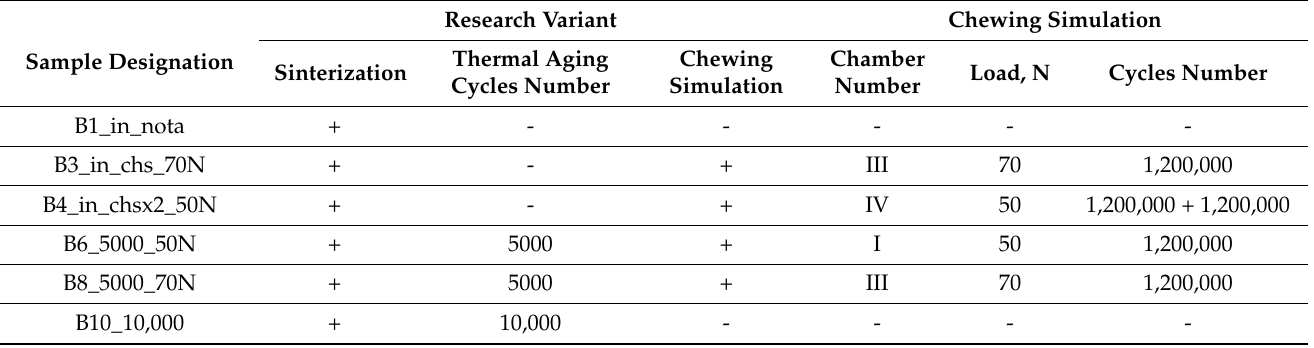
Table 1. Research variants and the legend of the designations of the samples subjected to the